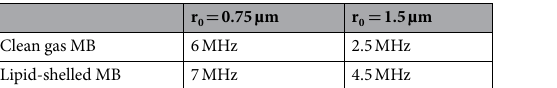
Table 1. The resonance frequency in MHz for clean gas MB and lipid-shelled MB, for resting radii (r 0 ) of 0.75 and 1.5 µ